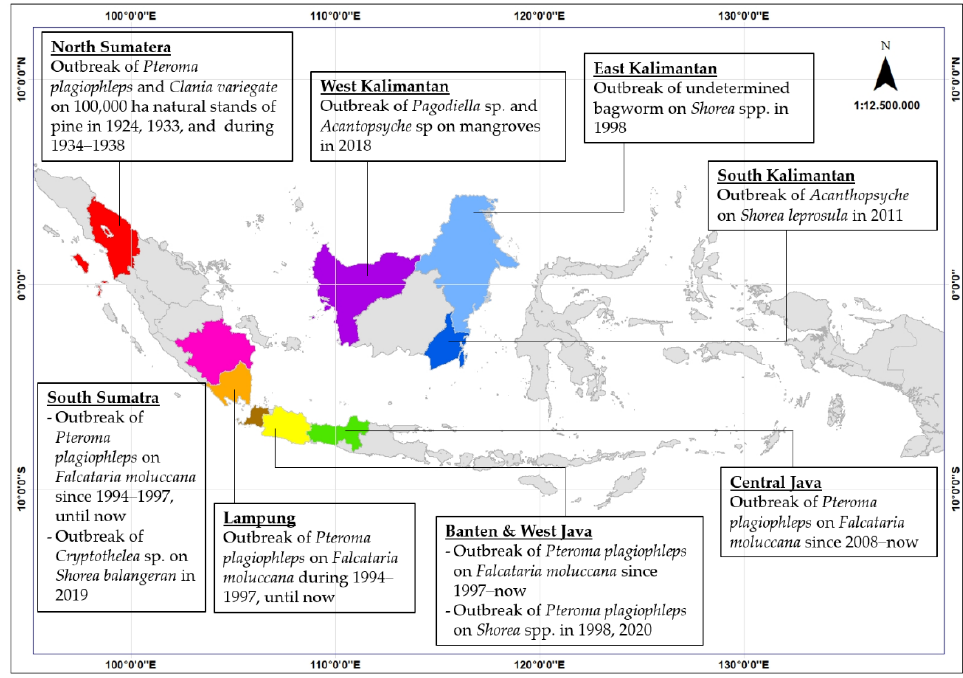
Figure 5. Bagworm outbreaks recorded in Indonesia. Most of these cases occurred in Western Indonesia. Different colors indicate the province where the outbreak of bagworms was reported.